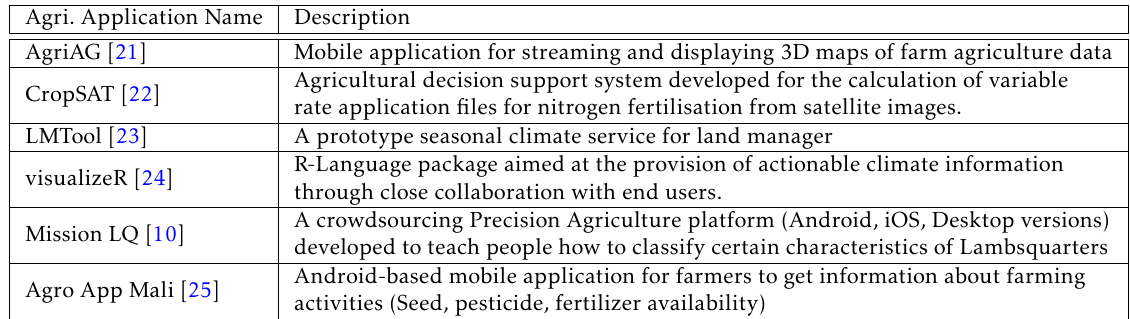
Table 1. Digital Agriculture Applications based on UCD Methodology